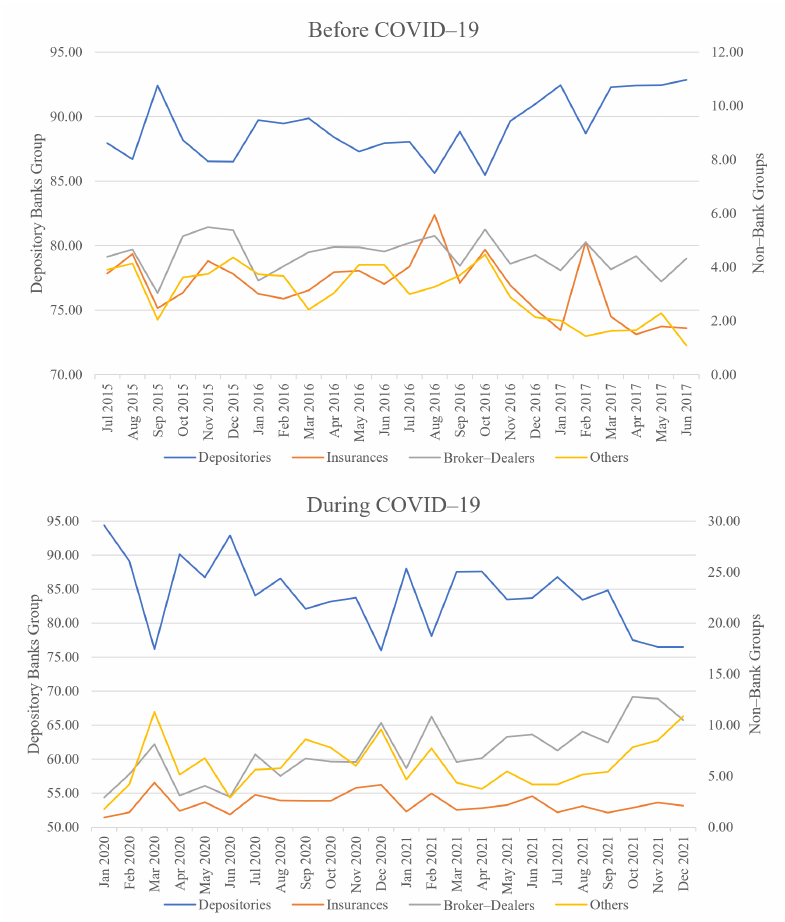
Figure 4. Monthly average CES% for four financial